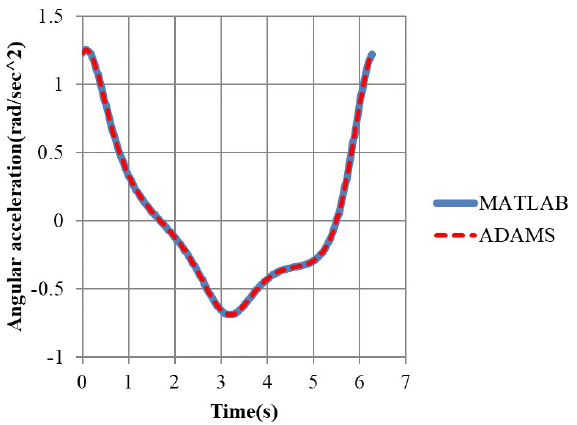
Figure 11. Comparison of our modeling computation with that of ADAMS on α 4 Figure 11. C omparison of our modeling computation with that of ADAMS on